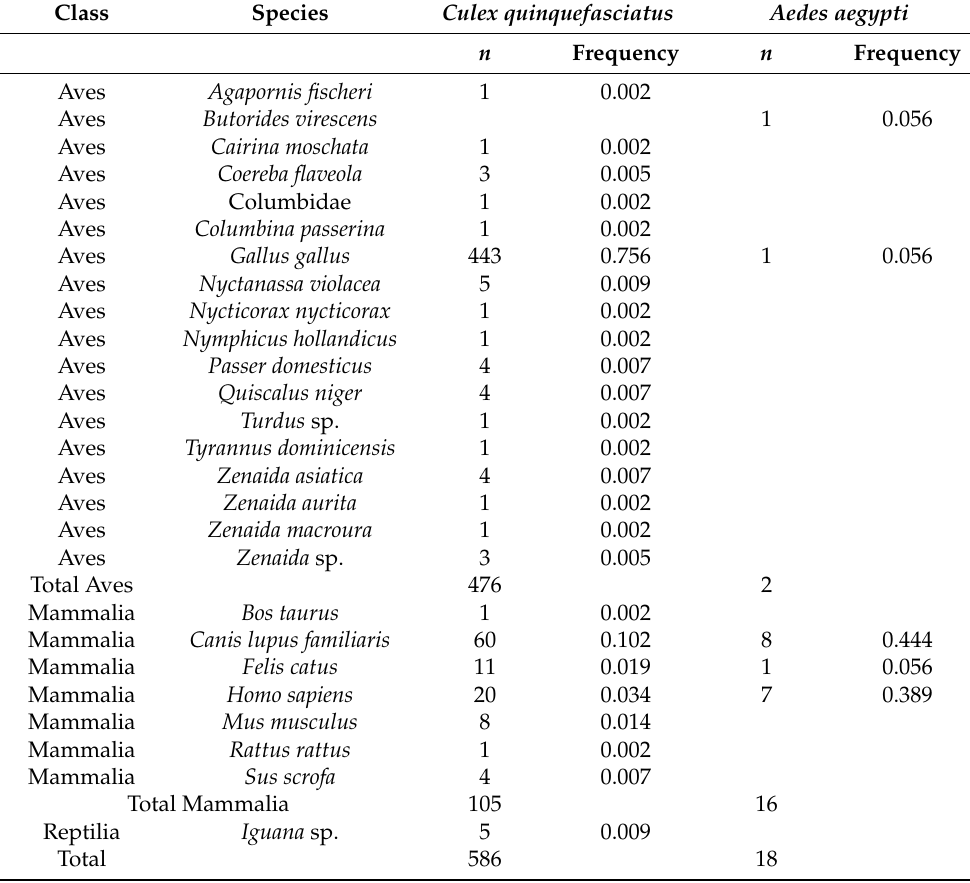
Table 2. Molecular blood meal identifications to class and species, number of times that species was detected in an individual mosquito ( n ) and frequency of identification for two mosquito species collected in the San Juan Metropolitan Area, Puerto